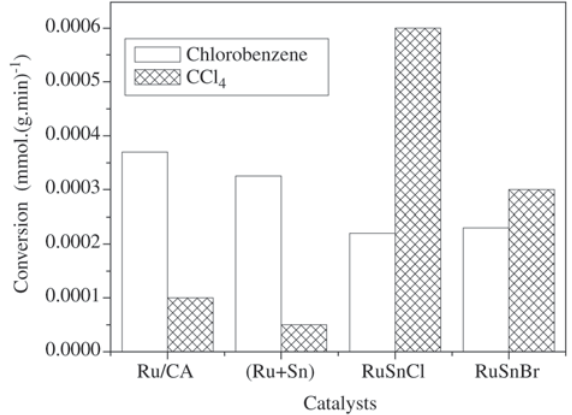
Figure 6. Hydrogendechlorination of CCl (at 200 °C) and 4 chlorobenzene (at 300 °C) in the presence of different RuSn cata- lysts. Scheme 1. 1,5-COD